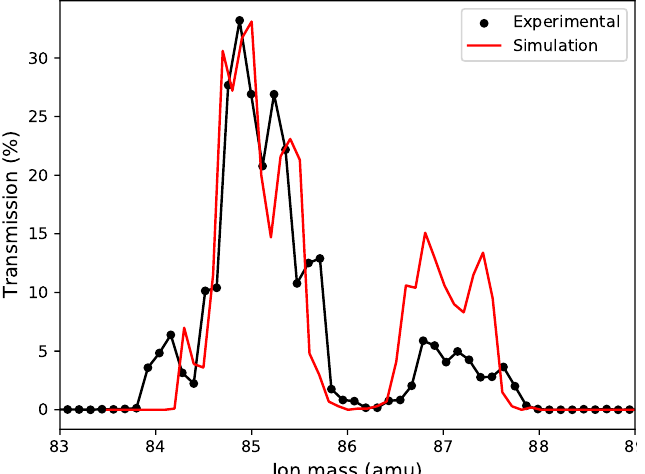
Figure 5. Experimental load–line scan of the QMF for a fixed DC to RF amplitude ratio of 0.166, compared with a SIMION simulation performed with the same parameters. The mass axis is calibrated so that the left peak corresponds to 85